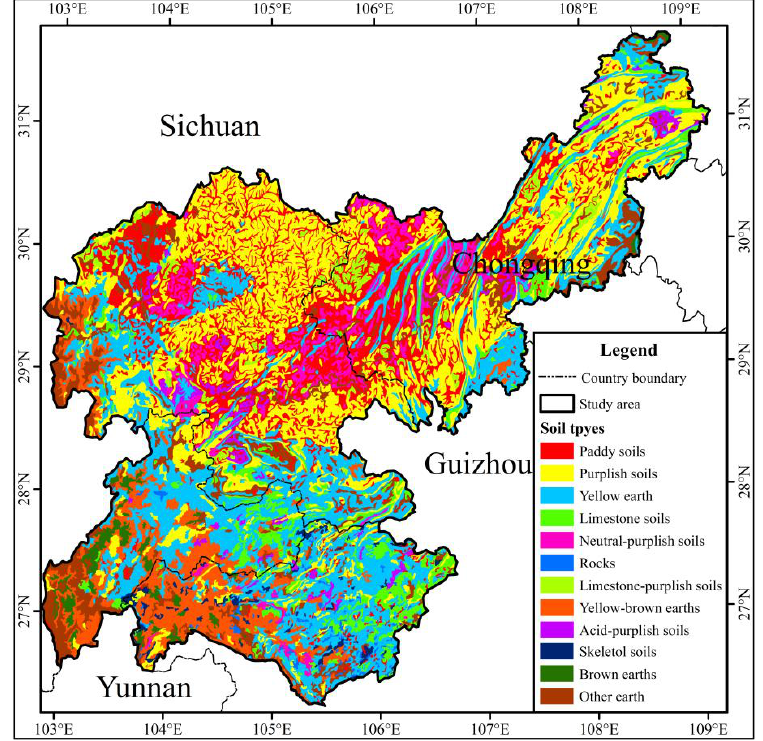
Figure 3. Map of soil types distribution.